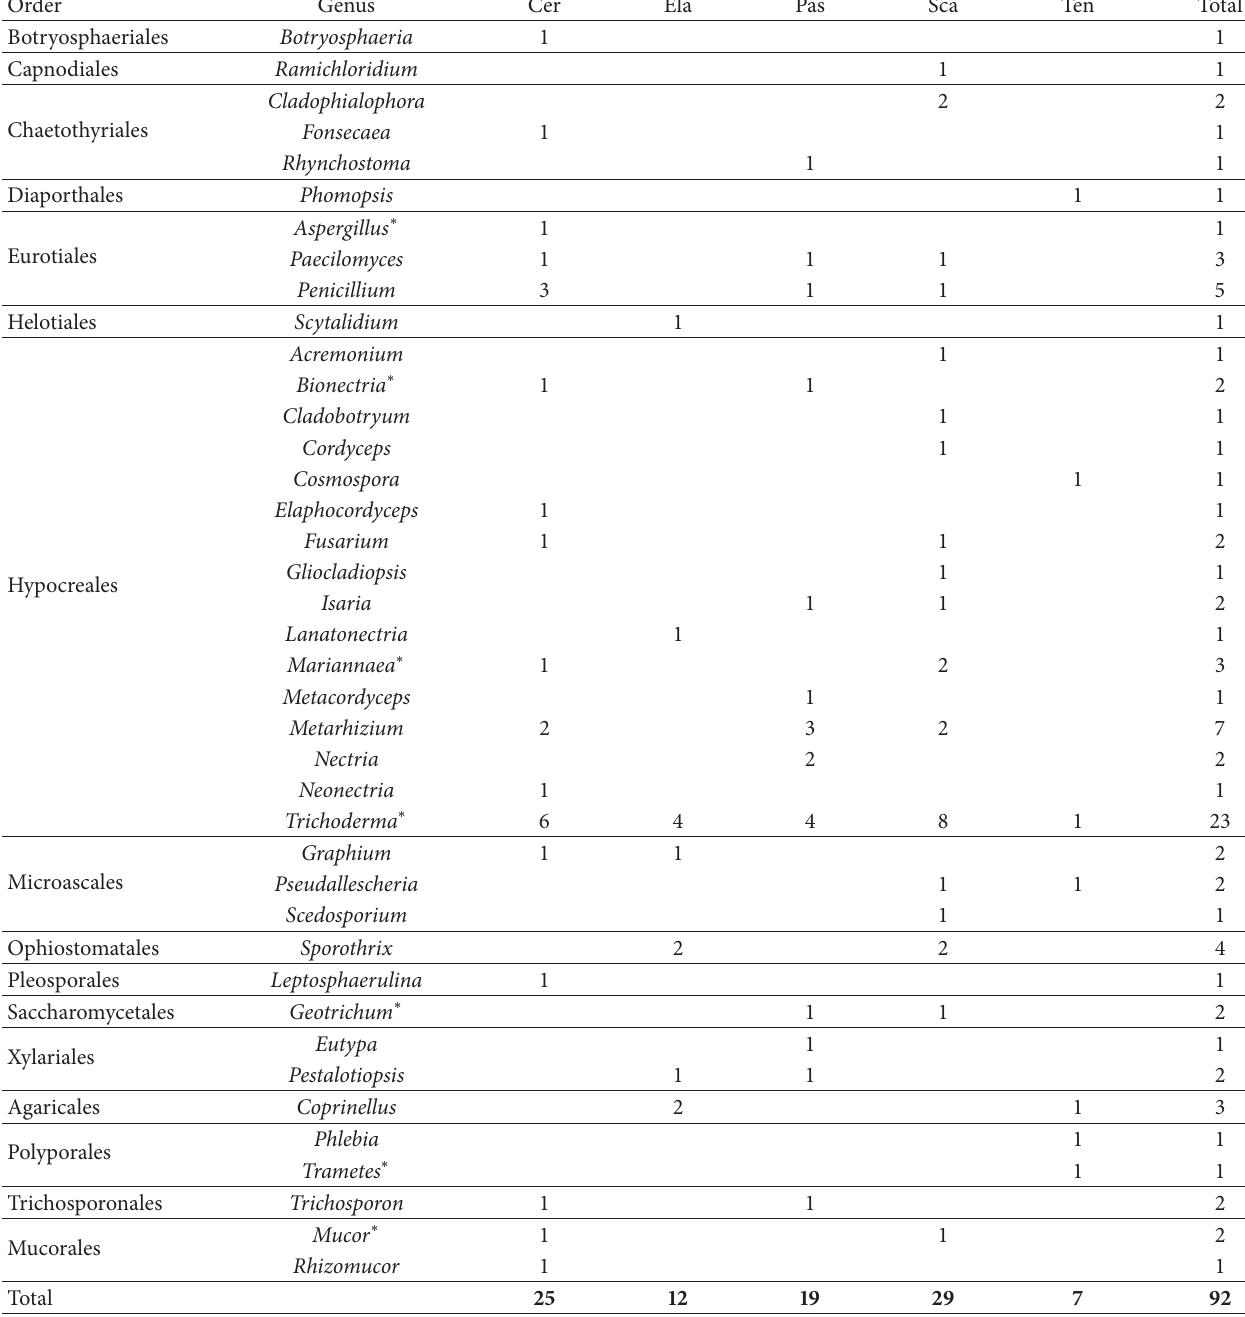
Table 3: Taxonomic distribution of the fungal isolates identified in this study. The number of isolates at the order and genera level is shown for each of the coleopteran